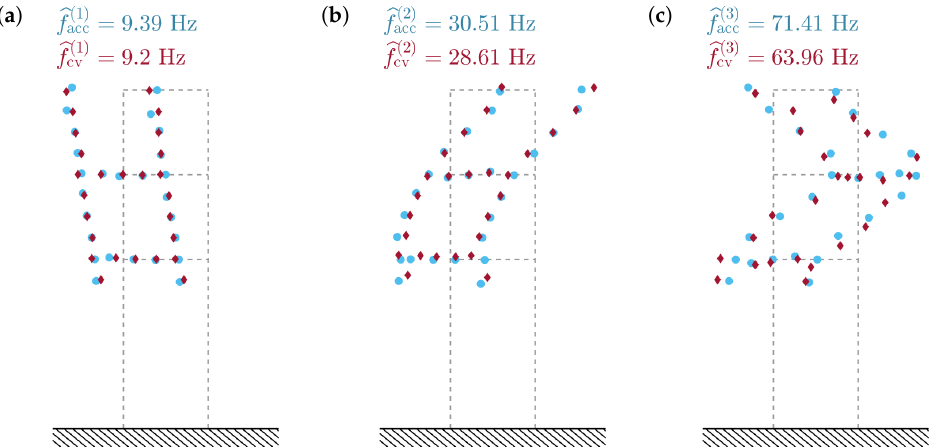
Figure 12. Comparison of the identified mode shapes obtained with accelerometers (blue dots) and smartphone camera (claret